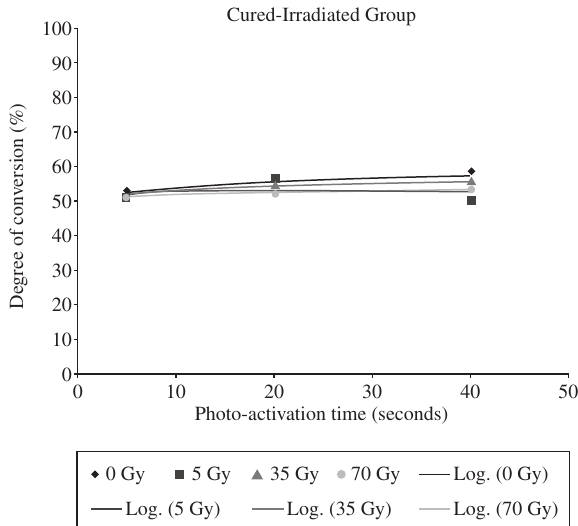
Figure 3. Regression analysis of degree of conversion of the Filtek Z250 TM material to uncured-irradiated groups in accordance with radiation dose as a function of the photo-activation time.